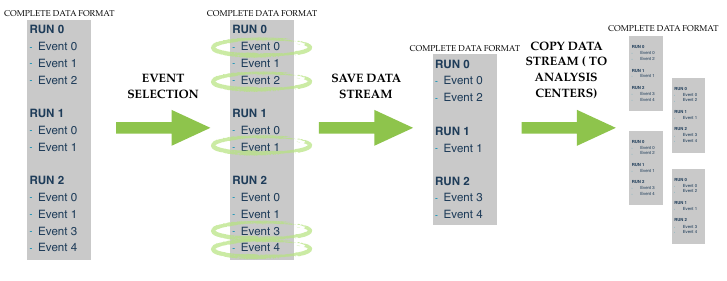
Figure 2. Production of data